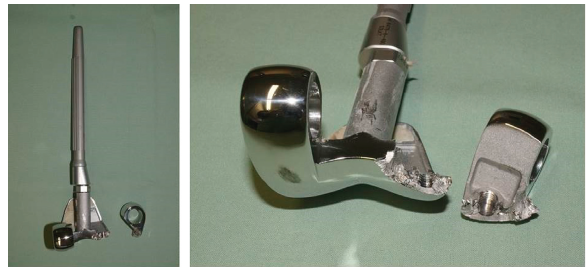
Figure 3: The evaluation of the fractured prosthesis area dem- onstrated that the breaking line ran through the thread hole where metal augmentation blocks can be added and secured in case of bony